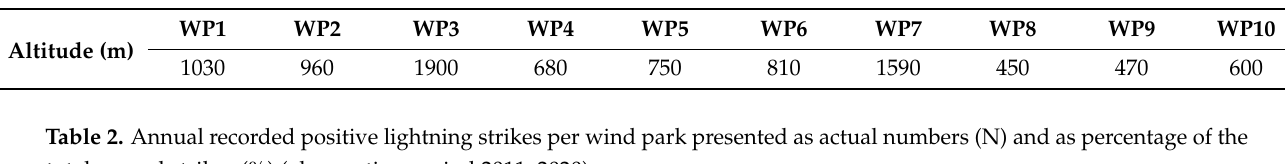
Table 1. Average altitude of the location of each wind park.